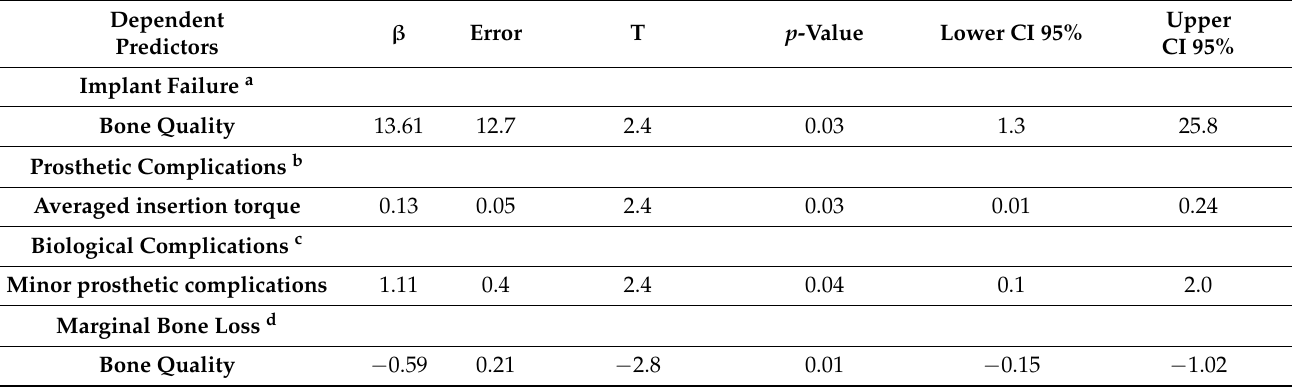
Table 5. Linear regression analyses to predict clinical treatment outcomes as a function of age, sex, cohort, initial torque, bone quality, gingival biotype, initial ISQ, and number of complications ( n =